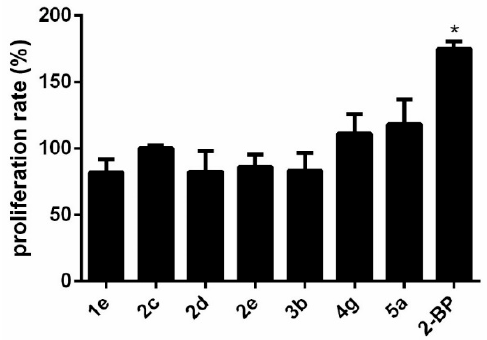
Figure 7. Proliferation rate of MCF-7 cells incubated with tested compounds at 5 µM. Compounds showed lack of proliferation-stimulating effect. BP-2 increased MCF-7 proliferation by over 60% ( p < 0.05).